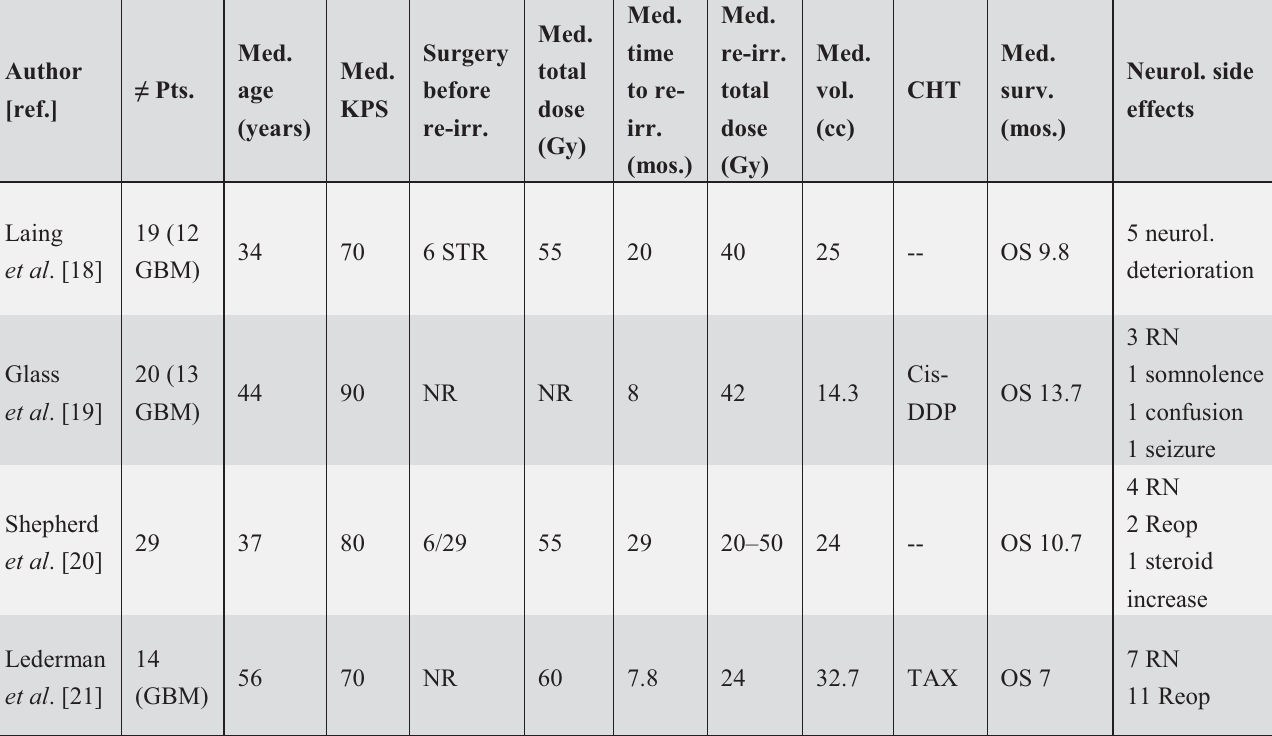
2. Re-irradiation with fractionated stereotactic radiation therapy with or without